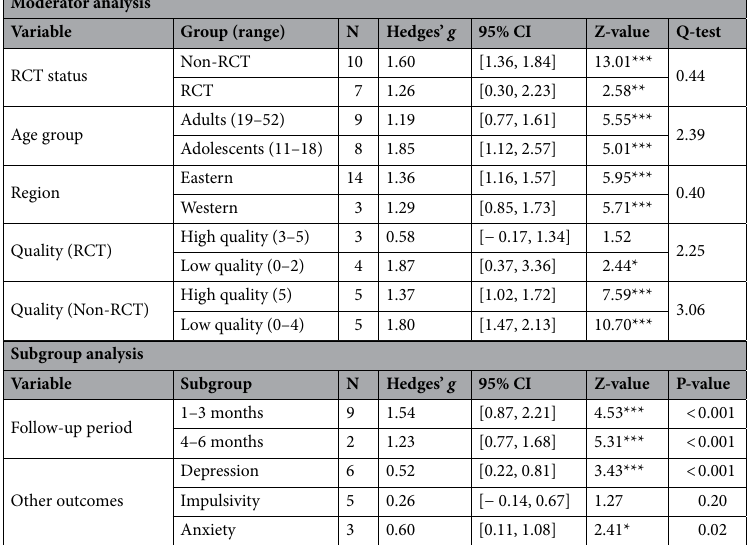
Table 2. Moderator and subgroup analysis. N = number of studies, CI = confidence interval, RCT randomized controlled trial. * p < 0.05, ** p < 0.01, *** p < 0.001.